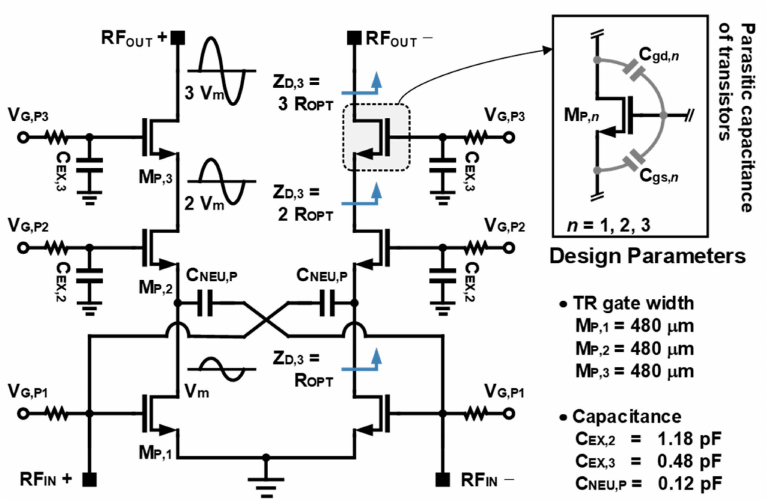
Figure 1. Schematic of the three stacked power stage with differential structure. With the result of Equation (3), the calculated and optimized values of C EX, 2 and C EX, 3 were 1.18 pF and 0.48 pF.